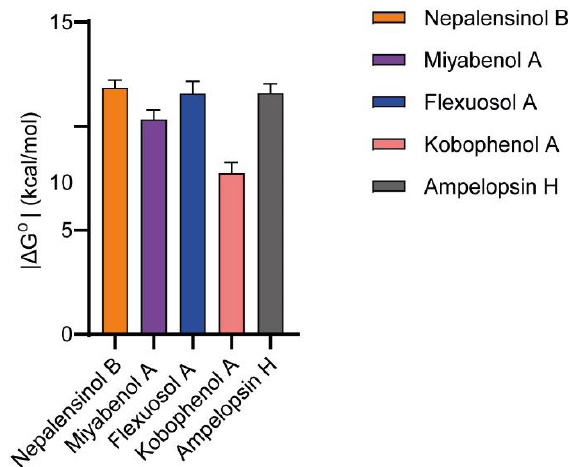
Figure 8. YANK-calculated values confirm the experimental observations for almost all ligands. Nepalensinol B remains the most active with the strongest estimated binding. Similar values are also observed in the case of Ampelopsin H. Miyabenol A is characterized by a moderate binding affinity, and finally, Kobophenol A shows the weakest binding. Flexuosol A shows a high binding affinity; however, its lower biological effect can be possibly due to further biological interactions or properties of the